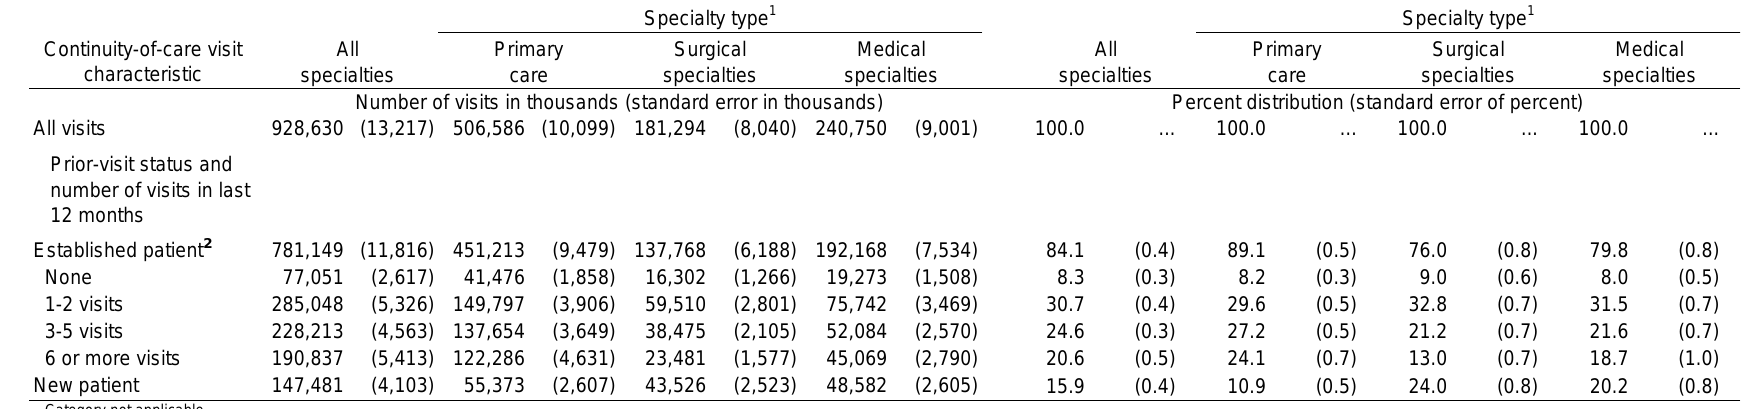
Table 10. Continuity-of-care office visit characteristics according to specialty type: United States,